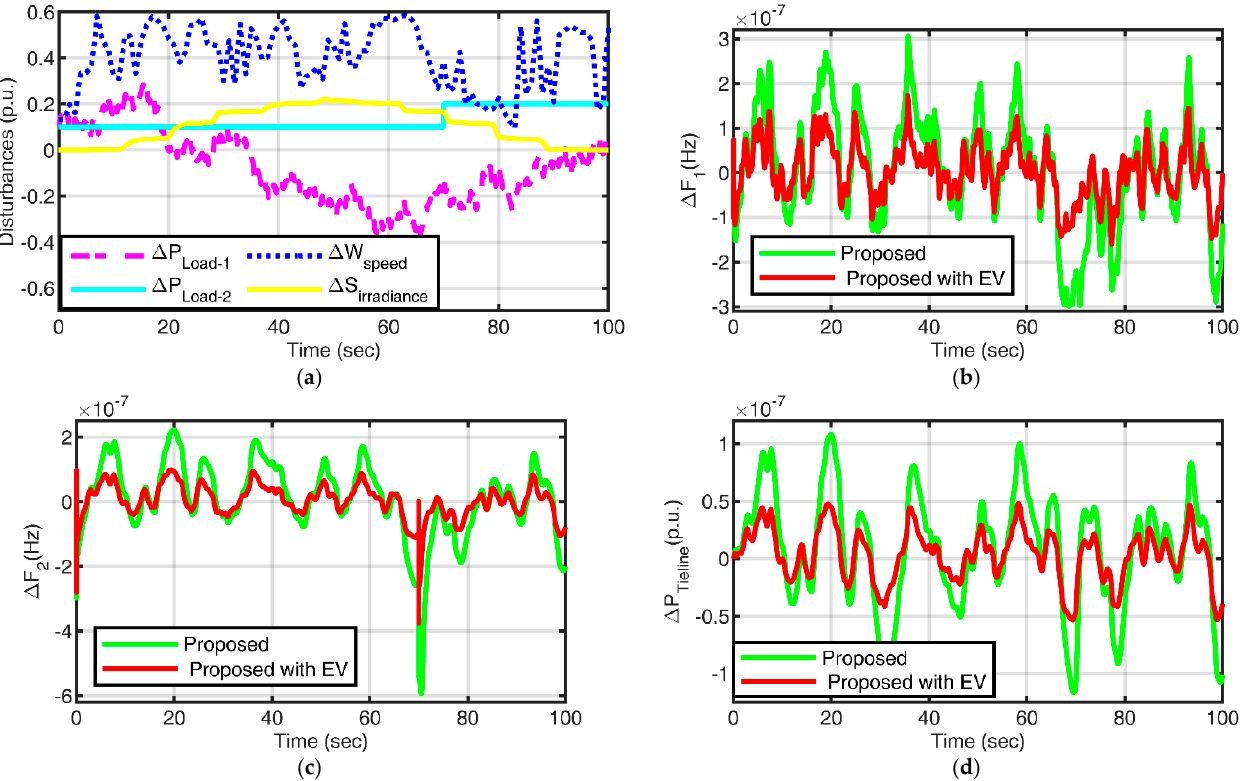
Figure 11. ( a ) Random variation in load, solar irradiance, and wind speed. ( b ) Frequency response of area 1 with the proposed control strategy. ( c ) Frequency response of area 2 with the proposed control strategy. ( d ) Tie-line power response with the proposed control strategy.